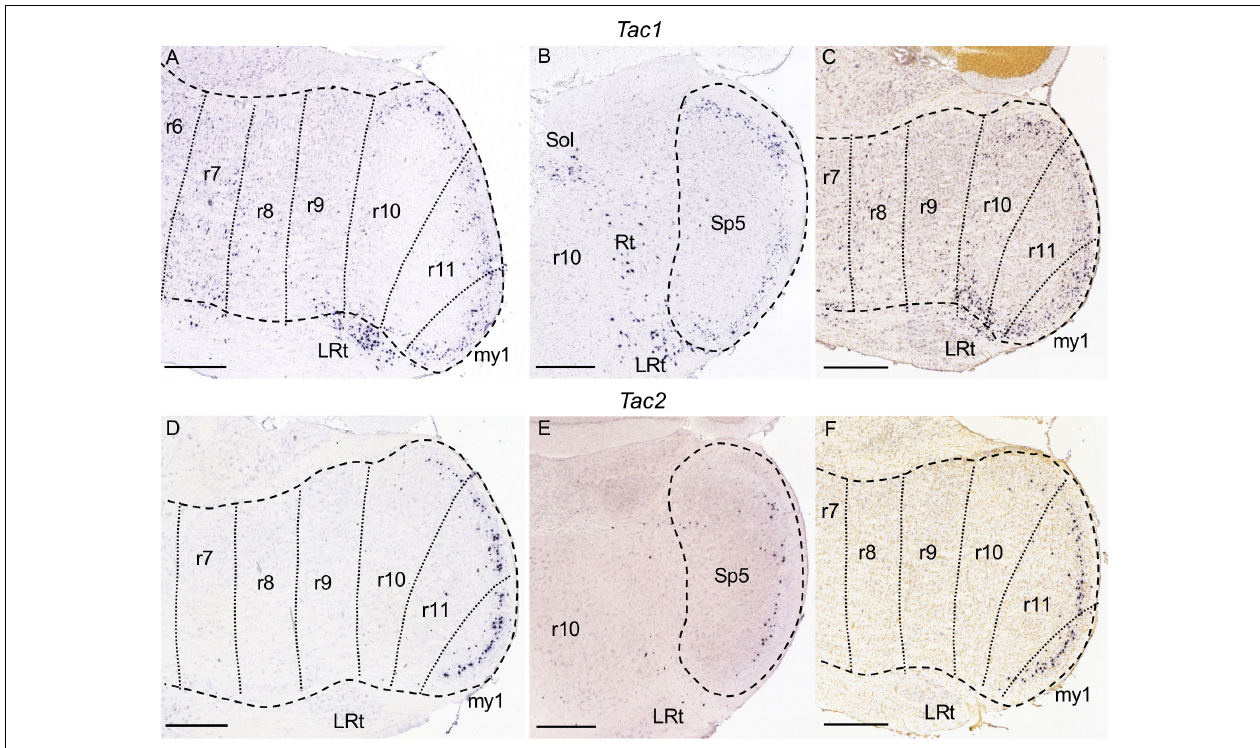
FIGURE 9 | Tac1 (A–C) and Tac2 (D–F) expression. In each image Pr5 and/or Sp5 are encircled by dashed lines. (A–C) Brightfield image details of a parasagittal (A) and a coronal (B) section from adult brains, and of a parasagittal section from a P28 brain (C) processed for detection of Tac1 expression. There is expression in the gelatinous layer of the r10 and r11 portions of Sp5, as well as in their caudal continuation in my1. Additionally, there are sparse positive cells from r7 to r9. There is expression also in the part of the lateral reticular nucleus (LRt) close to Sp5, as well as disperse cells in the solitary nucleus (Sol) and the medullary reticular formation (Rt). (D–F) Counterparts of the former images at similar levels, processed for Tac2 detection. There is a decreasing graded expression in the gelatinous layer of Sp5 from my1 to r10, while the other rhombomeres are negative. Scale bars = 500 µ